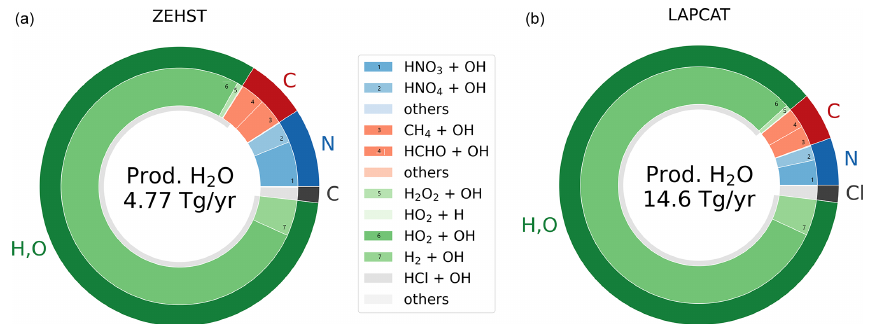
Figure 8. Pie plots on chemical reactions responsible for H 2 O production derived from the EMAC simulation results (scenario–reference). (a) ZEHST scenario. (b) LAPCAT scenario. The darker outer ring shows the molecular category the reactions belong to (carbon-, nitrogen-, chlorine-, or hydrogen-based). The total sum of H 2 O production is written in the center. The colored inner ring shows the proportion of different reactions within each category. We added black numbers in the legend and in the bright inner ring to represent the relation in addition to colors.